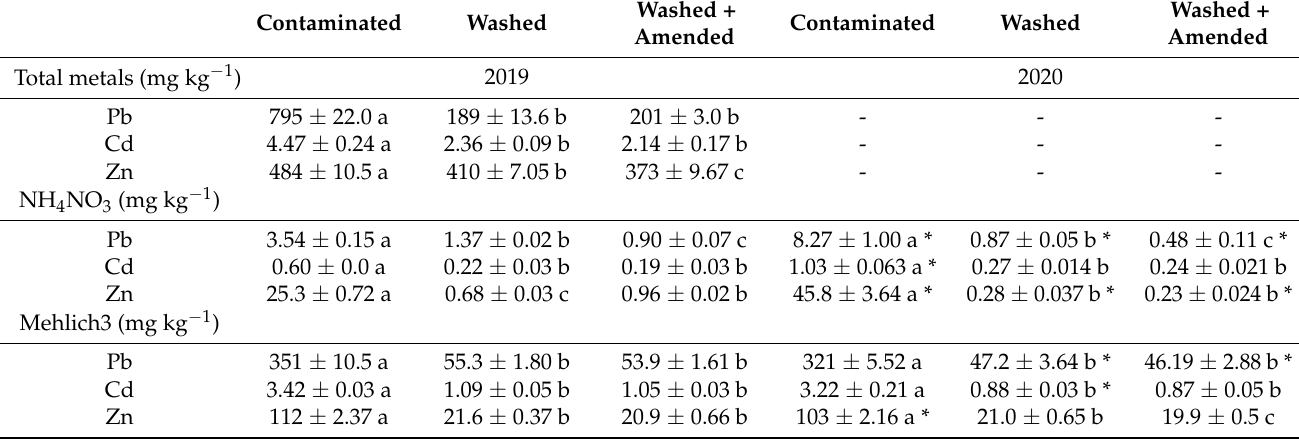
Table 3. Total, NH 4 NO 3 extractable, and potentially plant available (Mehlich-3) metal pools (mean ± SD, n = 4). Lower case letters indicate significant differences between groups of one sampling event. Asterisks indicate significant differences between 2019 and 2020 of one